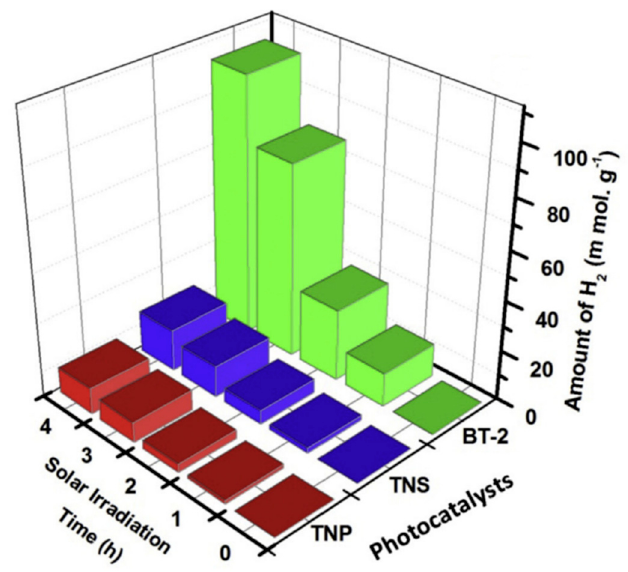
Figure 5. Solar photocatalytic activity comparison of TiO 2 P-25 nanoparticles (TNP), a non-modified TiO 2 nanostructure (TNS) and the Bi 2 O 3 -modified nanostructure (BT-2) [29]. Reprinted with permis- sion from ref. [29]. Copyright 2017 Elsevier.